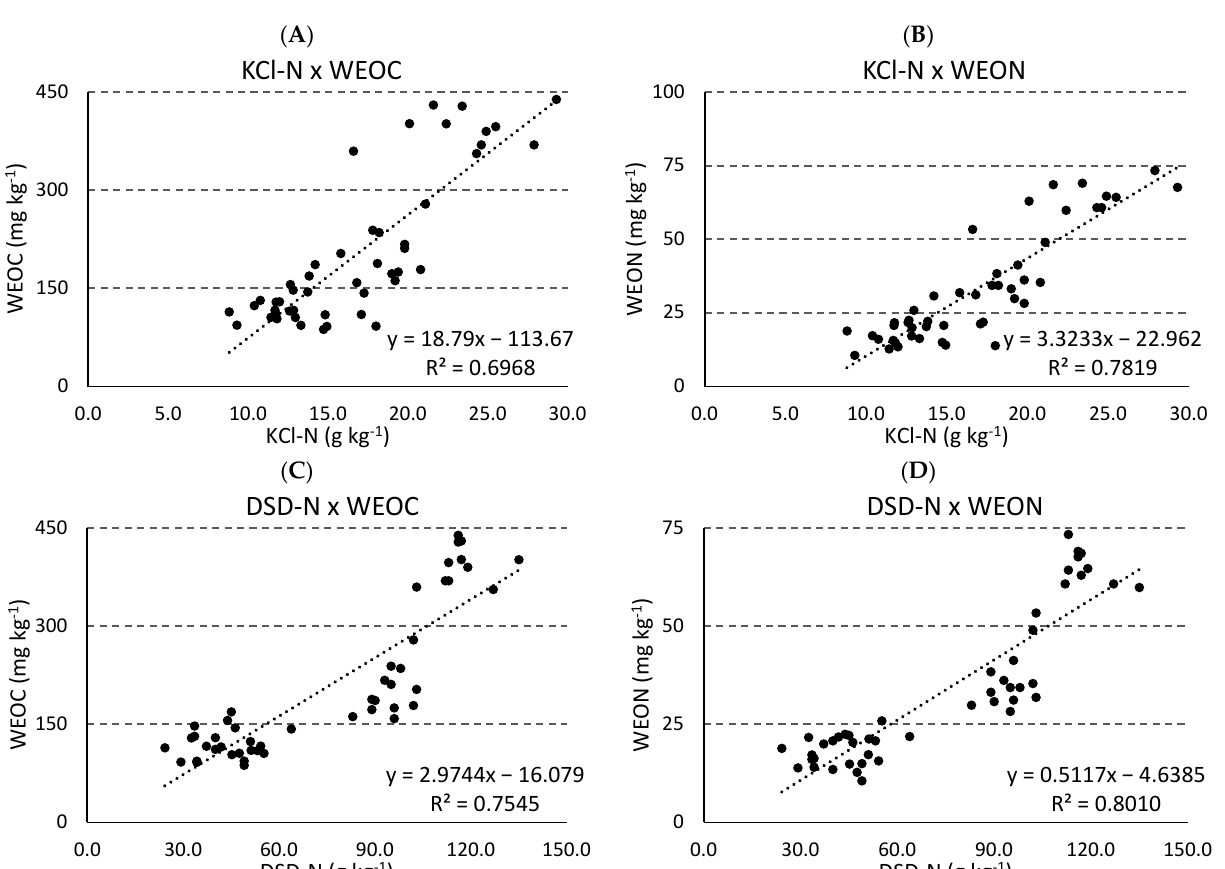
Figure 3. Linear relationship between potentially available nitrogen extracted with hot KCl solution and direct steam distillation and water extractable carbon and nitrogen; hot KCl and water extractable organic carbon ( A ); hot KCl and water extractable organic nitrogen ( B ); direct steam distillation and water extractable organic carbon ( C ); and direct steam distillation and water extractable organic nitrogen ( D ). Equations and coefficients of determination are displayed in each graph. Table 8. Correlation coefficients among soil carbon and nitrogen forms, nitrogen fractions, and potentially available nitrogen observed in a long-term no-till experiment with different cover crops and nitrogen fertilizer doses.